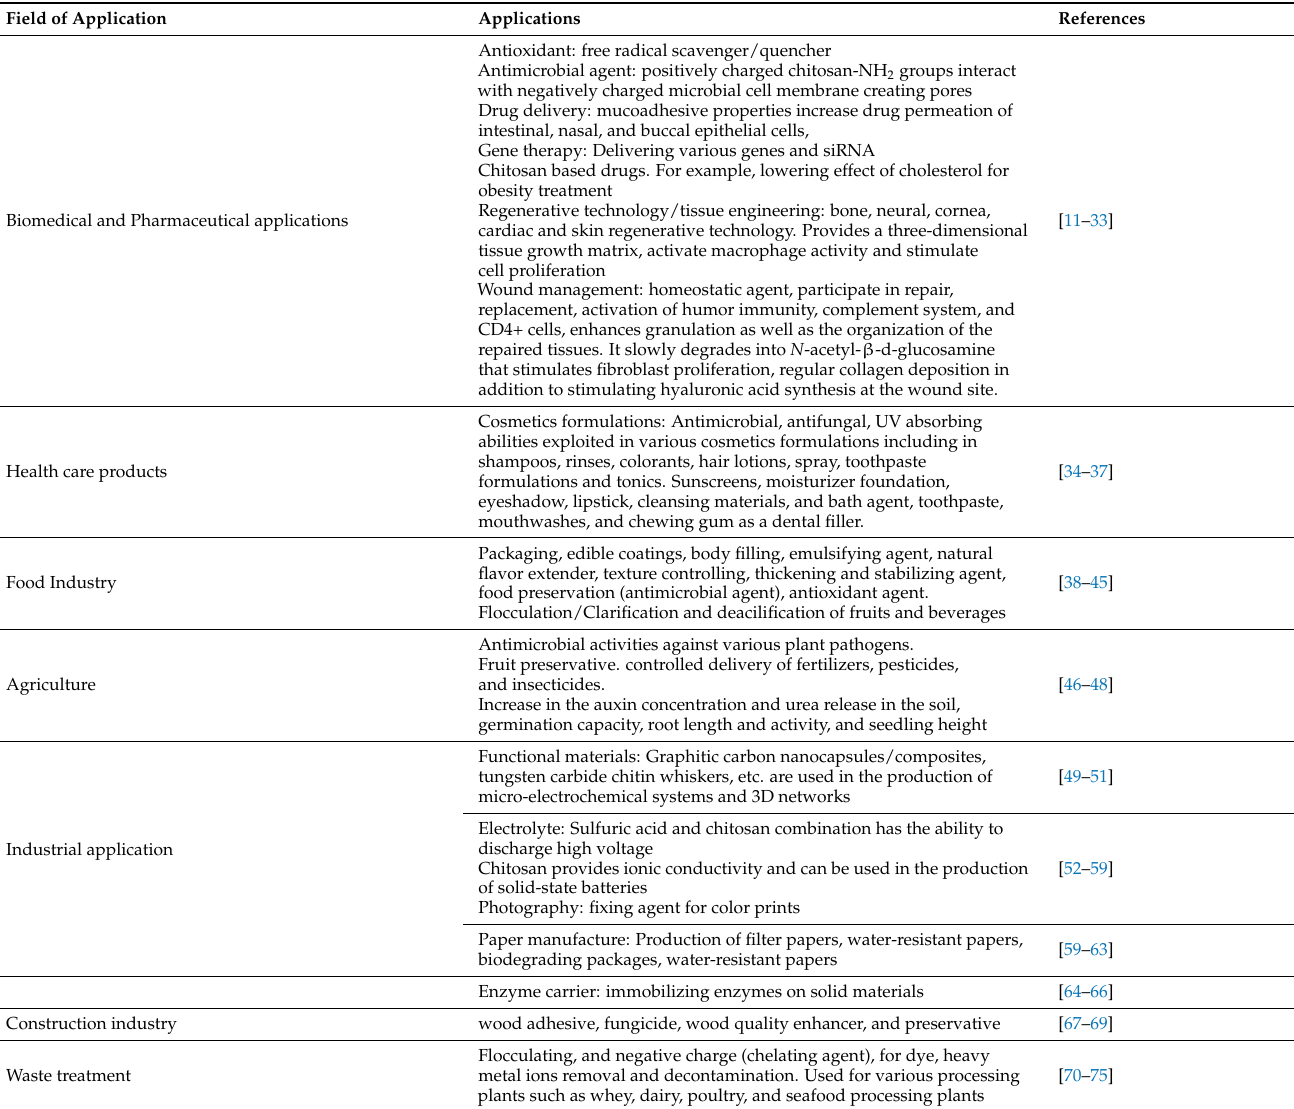
Table 1. Summary of major applications of chitin and chitosan in the different